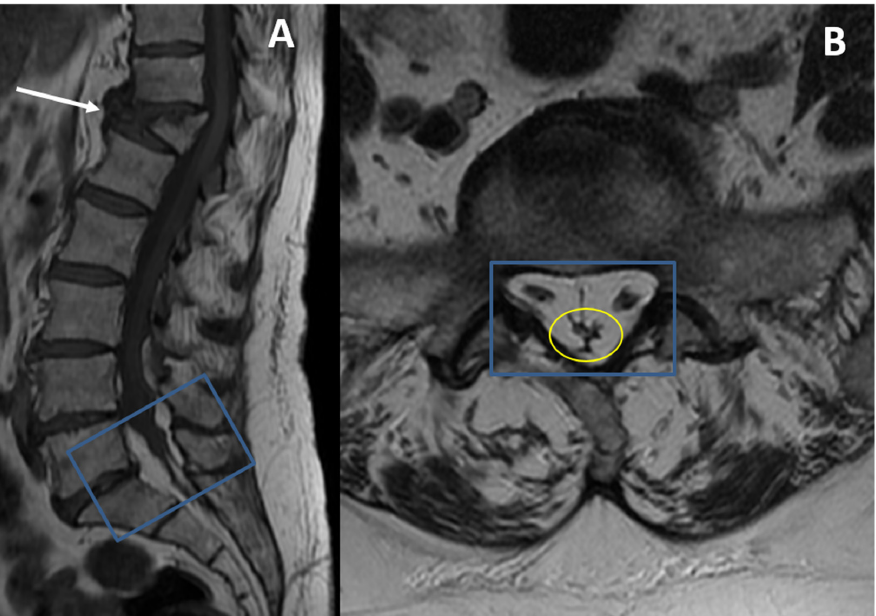
Figure 2. A 72-year-old woman affected by dyslipidemia, obesity, and high blood pressure underwent follow-up MRI control for a vertebral fracture (T12); patient complained about chronic lumbar pain, which worsened after the fracture, and bilateral sciatica. ( A ) Sagittal T1-weighted imaging (WI); ( B ) axial T1-WI. A marked vertebral body collapse of the T12 vertebra is detectable (white arrow). Moreover, a condition of SEL at L5-S1 level (blue rectangles) with compression of the thecal sac resembling the letter “Y” (yellow oval) is found.